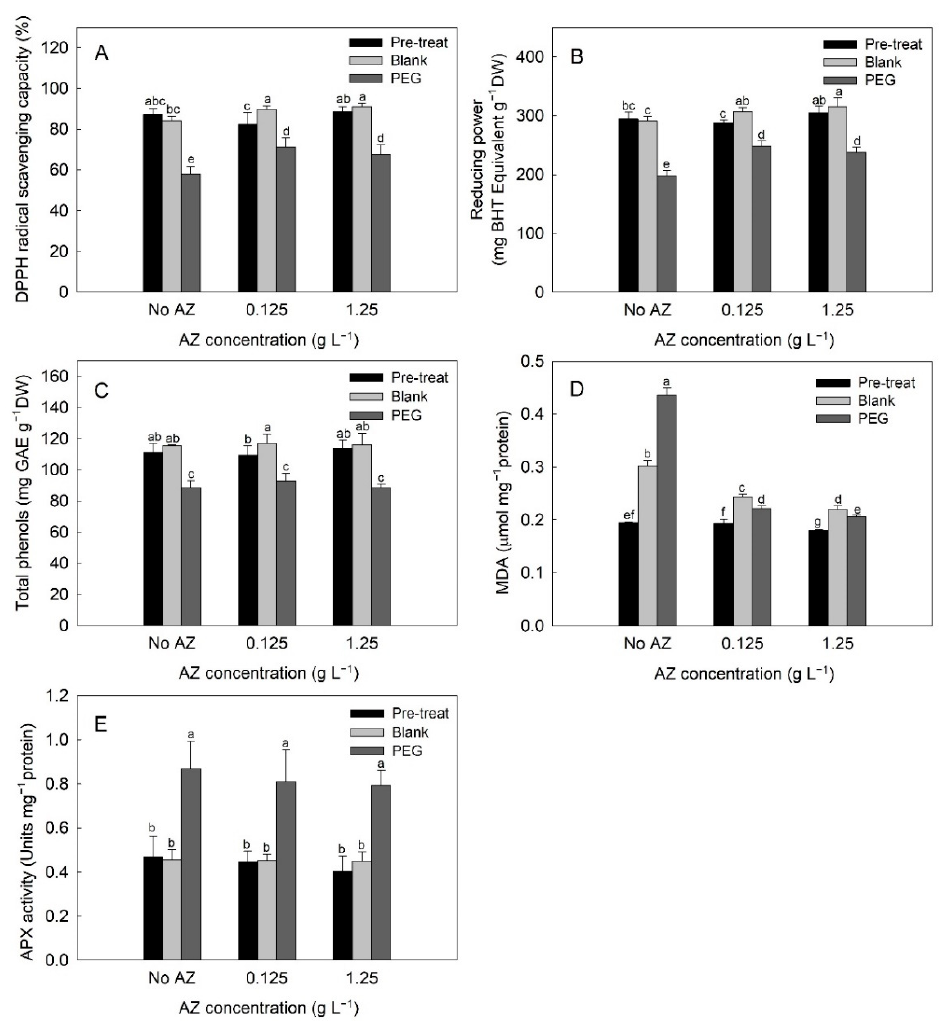
Figure 7. Change in DPPH radical scavenging capacity ( A ), reducing power ( B ), total phenols ( C ), malondialdehyde (MDA) ( D ), and ascorbate peroxidase (APX) activity ( E ) of tea leaf discs with pre-treatment (Pre-treat) of three different azoxystrobin (AZ) levels and then treated with blank solution (Blank) and PEG-induced osmotic stress (PEG), respectively. Values are the means (n=4) with standard errors shown by vertical bars. Different letters (a–g) represent statistically different means (LSD, p < 0.05). Total phenol in leaf discs after 1-day pretreatment was 109.3 − 114 mg GAE g − 1 DW. A